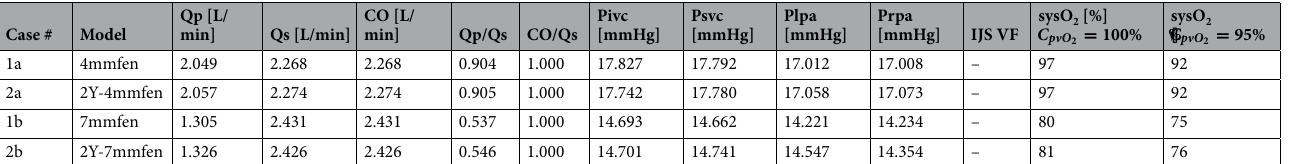
Table 1. Summary table of baseline (4 mm fenestration), enlarged fenestration (7 mm fenestration) and without IJS implementation (Model nomenclature: [TCPC topology] − [fenestration diameter]). Pulmonary venous saturations range C pvO 2 =